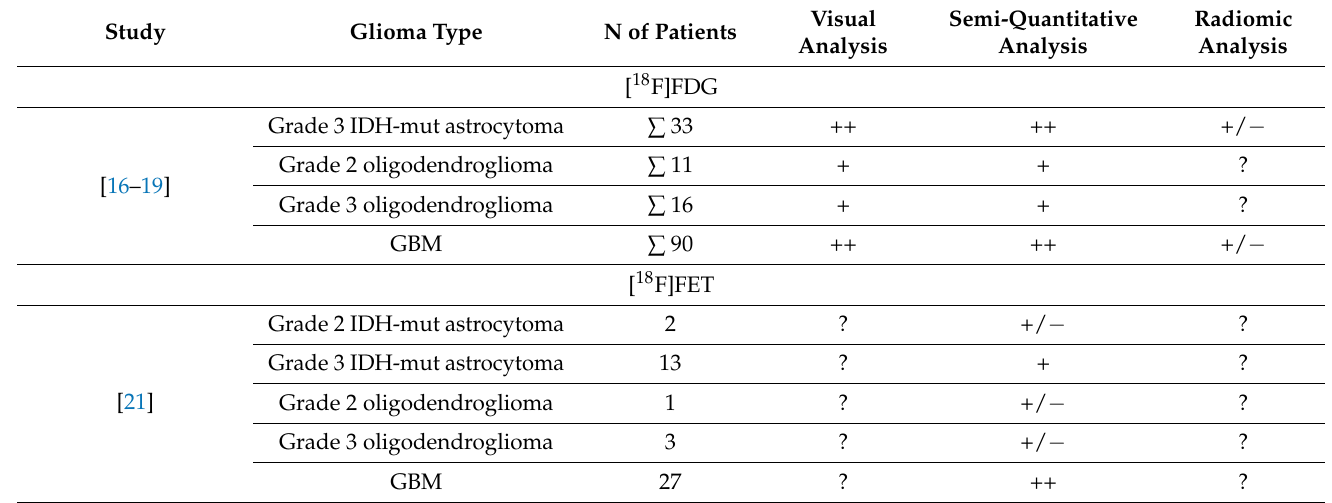
Table 7. Summary of the performance of different PET tracers and analyses according to glioma